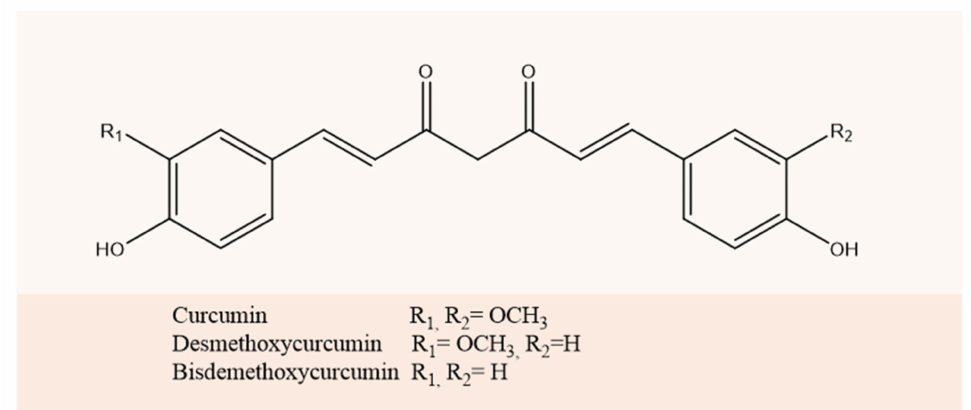
Figure 1. Chemical structure of